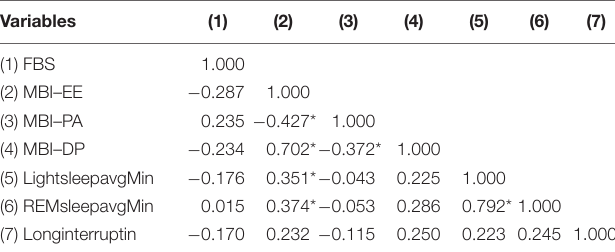
TABLE 4 | The regression models for Fuster-BEWAT score (FBS) with Maslach Burnout Inventory (MBI) emotional exhaustion (MBI-EE), depersonalization (MBI-DP), and personal accomplishment (MBI-PA) subscale scores ( N = 388).